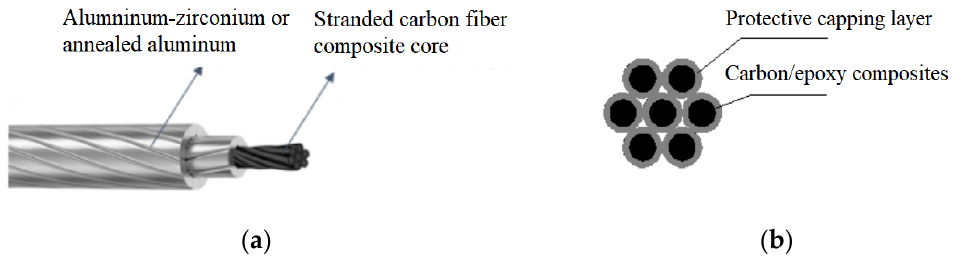
Figure 1. Structure of a stranded carbon fiber conductor: ( a ) carbon fiber composite core conductor; ( b ) stranded carbon fiber composite core.